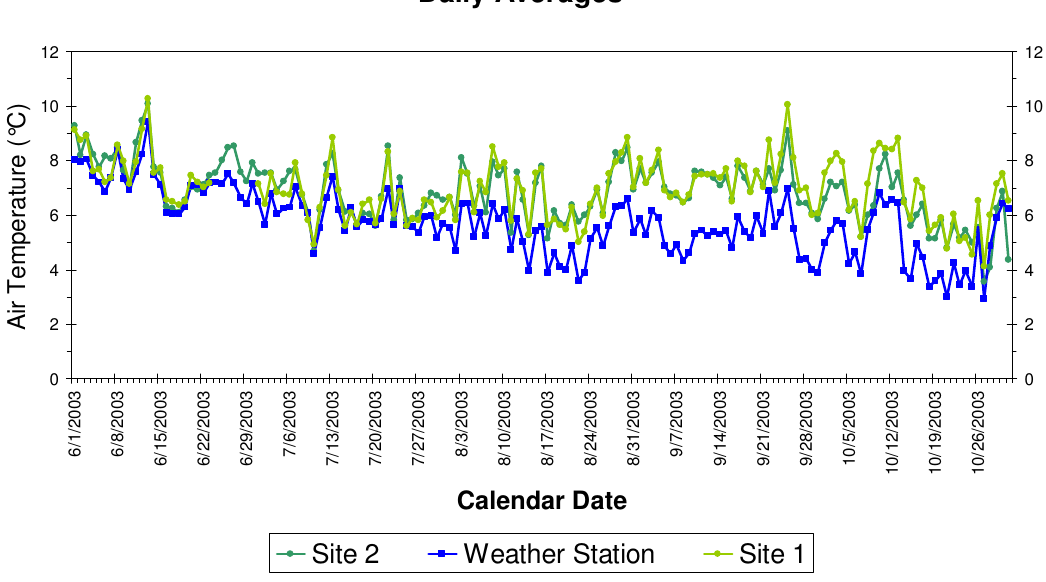
Figure 3. Time series graph of mean daily air temperature measured at the two dendrometer sites, showing good agreement between them, and also with values recorded by the automated weather station (see [41] for details on site